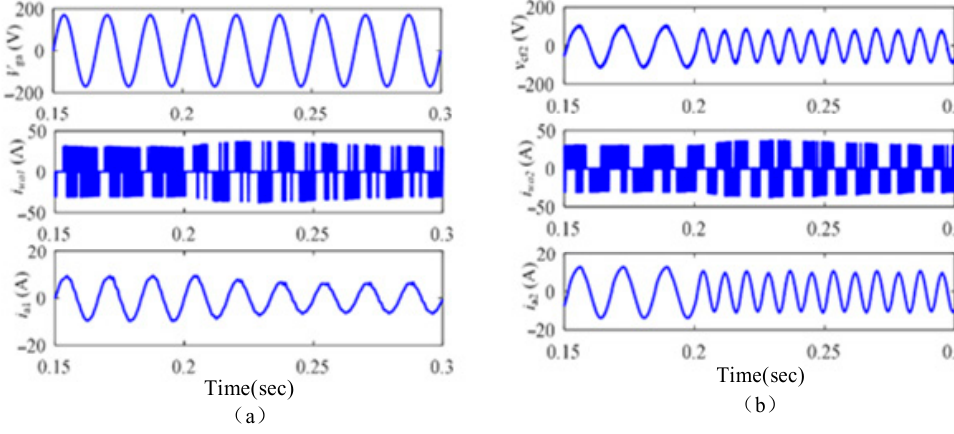
Figure 11. Dynamic performance; ( a ) rectifier side, ( b ) inverter side.